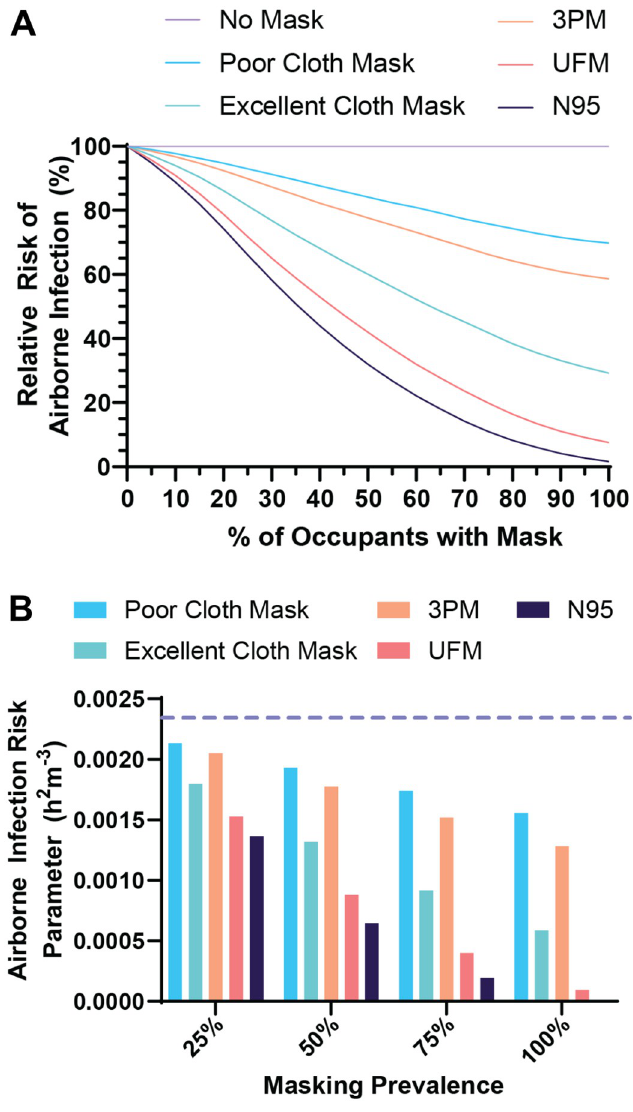
Fig 6. Model of airborne infection risk by mask type and usage. (A) The relative risk of a new airborne infection occurring in a classroom type environment with varying rates of masking and mask types. (B) The calculated individual infection risk parameter for individuals riding a subway train, assuming the presence of an infective individual. The dashed purple line indicates the risk parameter for no